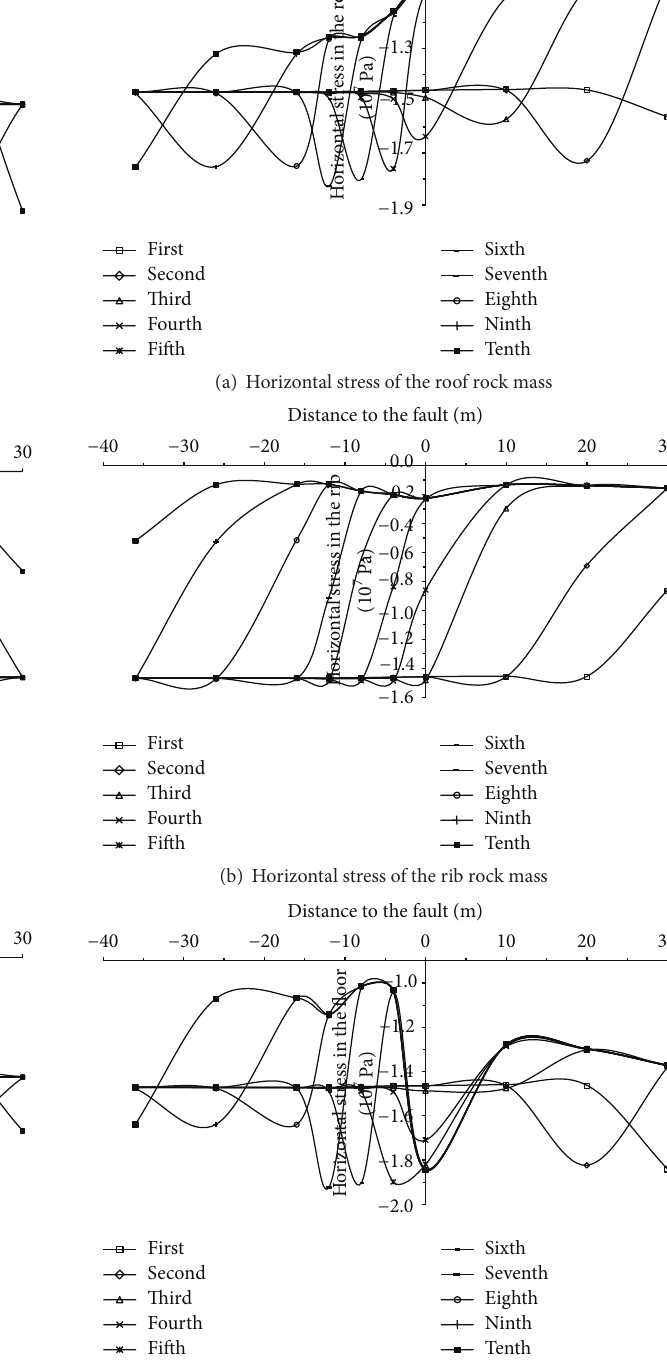
Figure 12: Horizontal stress of the surrounding rocks when the roadway passes from the hanging wall to the foot wall. Note: first to tenth denotes the excavation